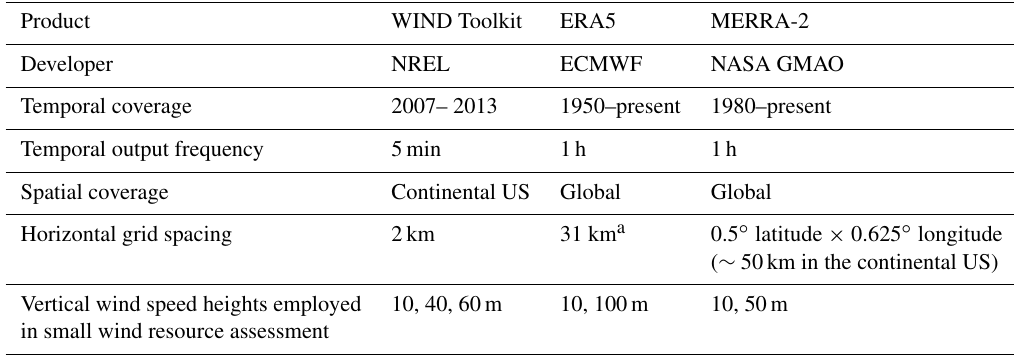
Table 1. Characteristics of the models and reanalyses that produce wind speed estimates. Product